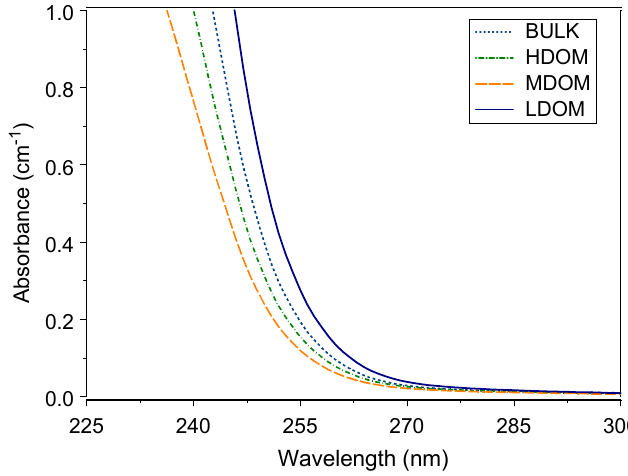
Figure 1. UV-Vis absorbance curve of bulk and size-fractioned Figure 1. UV － Vis absorbance curve of bulk and size － fractioned DOM.